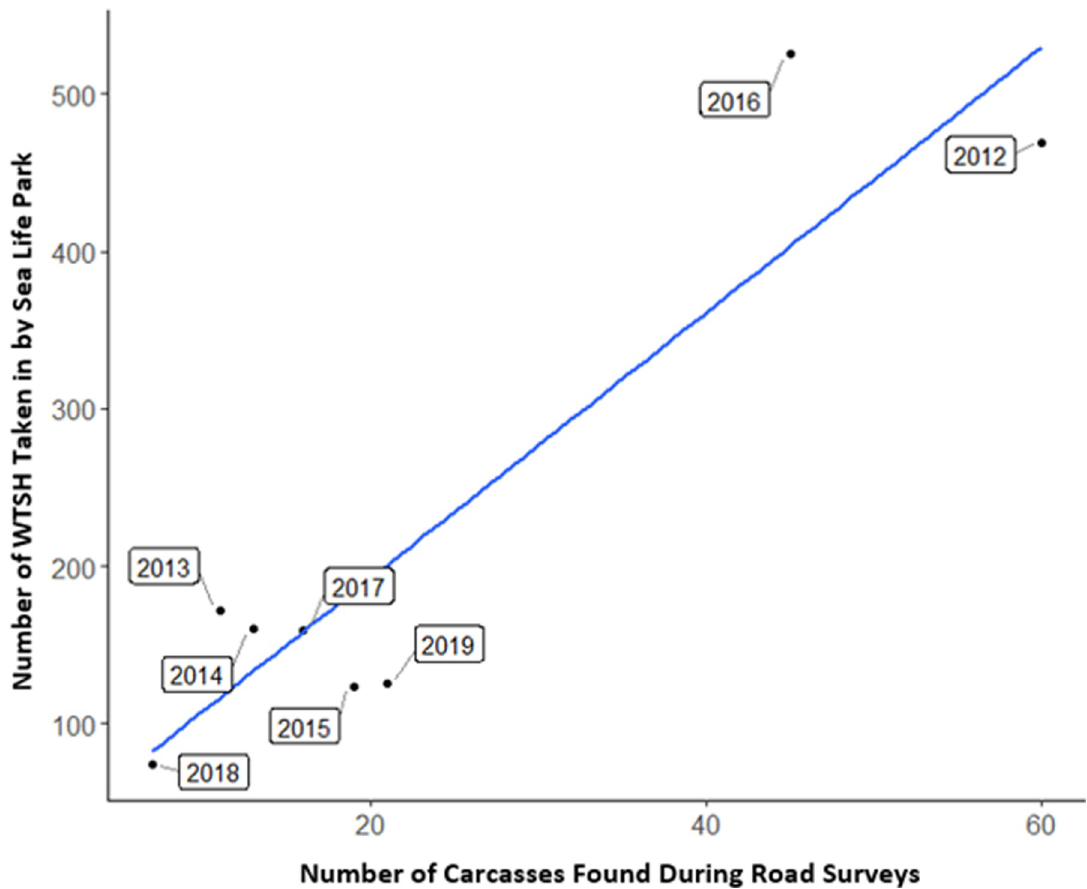
Fig 2. Fallout comparison between Sea Life Park intake records and road surveys. Scatterplot showing the total rescued WTSH per year from Sea Life Park intake records versus the total WTSH carcasses documented per year during road surveys (r 2 = 0.85).